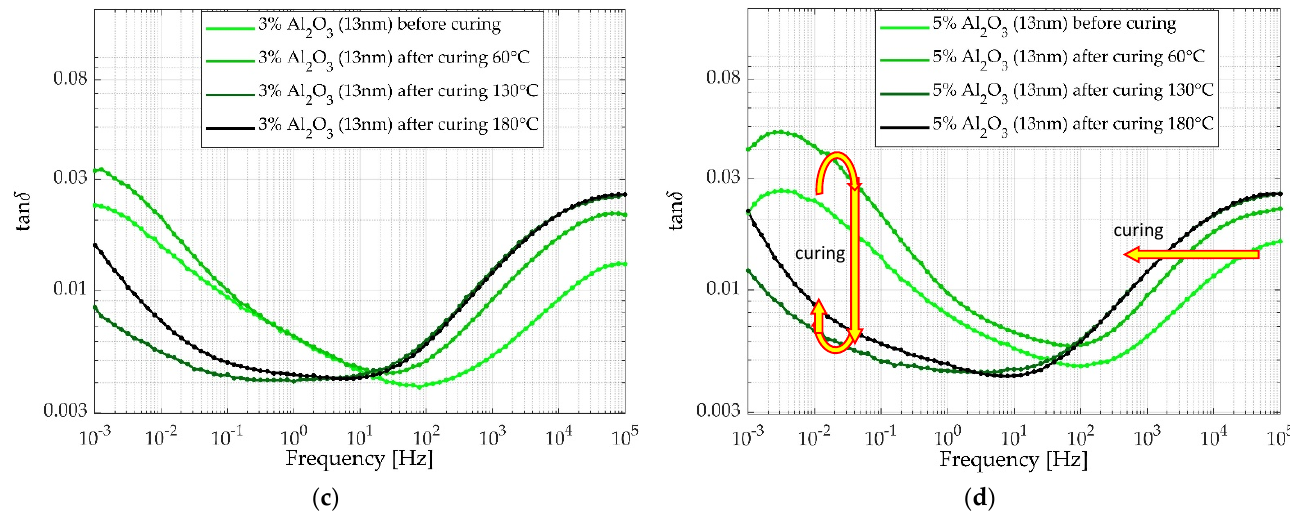
Figure 9. Broadband dielectric loss factor tan δ ( f ) characteristics for samples with Al 2 O 3 , with particles 13 nm and different wt% loadings: ( a ) 0.5%, ( b ) 1%, ( c ) 3%, ( d ) 5%.